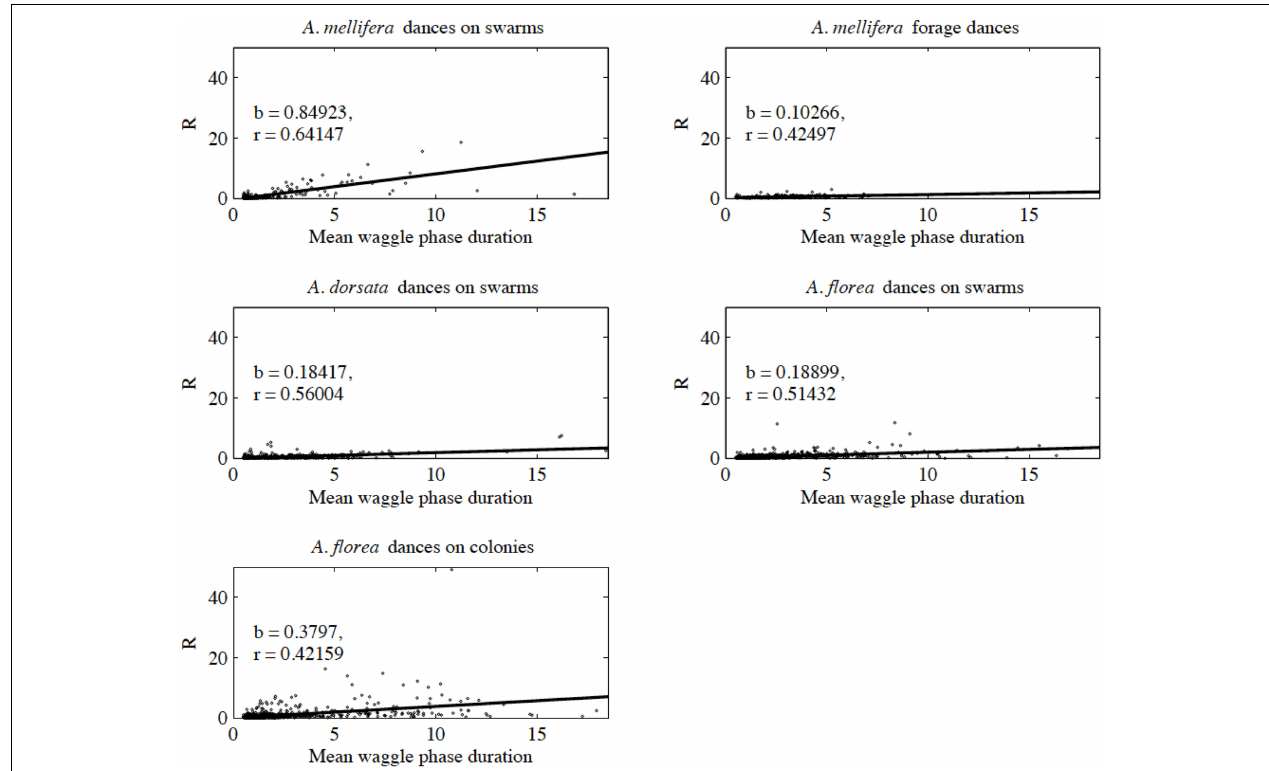
FIGURE 3 | Estimated radius ( R ) of the patch advertised within a dance against mean waggle phase duration. The solid line is the line of best fit (see Table 9 for details of the linear regression analyses).